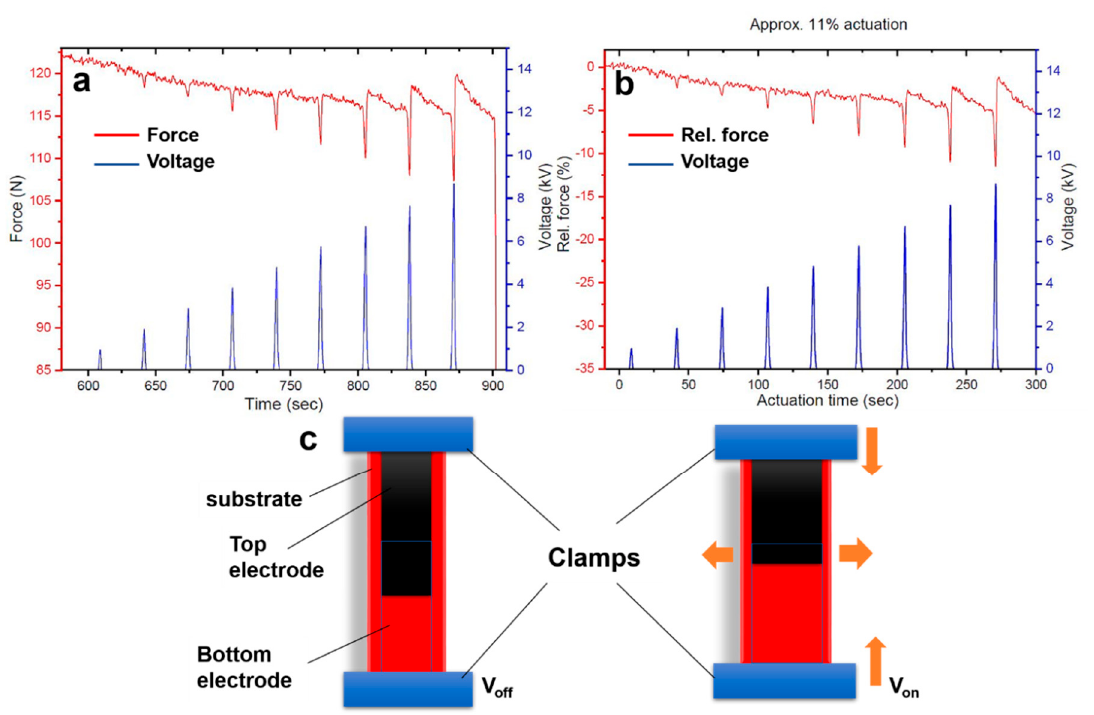
Figure 4. ( a , b ) actuation profile of HNBR substrate in terms of force and relative force (%), respectively, ( c ) schematic illustration of the mechanism of actuation for HNBR ( c ) schematic illustration of the mechanism of actuation for HNBR substrates.